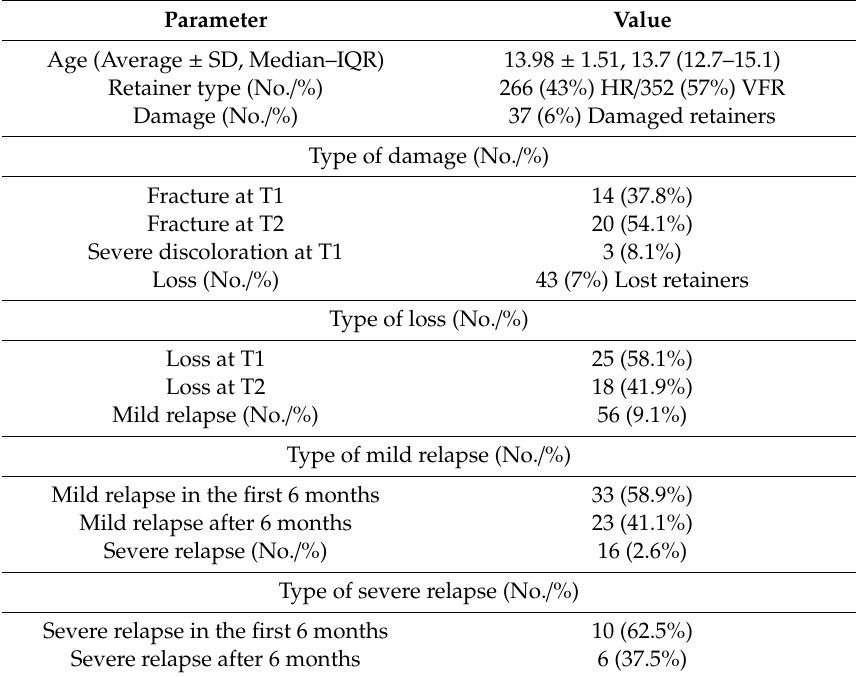
Table 1. Characteristics of the studied